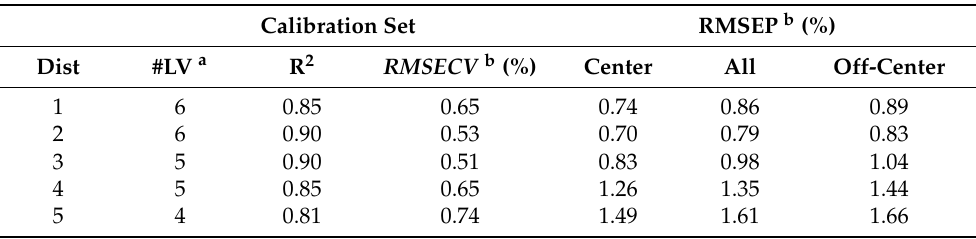
Table 3. Calibration results for potatoes with skin measured in motion for Dist1–Dist5. Prediction errors (RMSEP) are listed for center, off-center and all scans for the different distances. Calibration Set RMSEP b (%) Dist #LV a R 2 RMSECV b (%) Center All